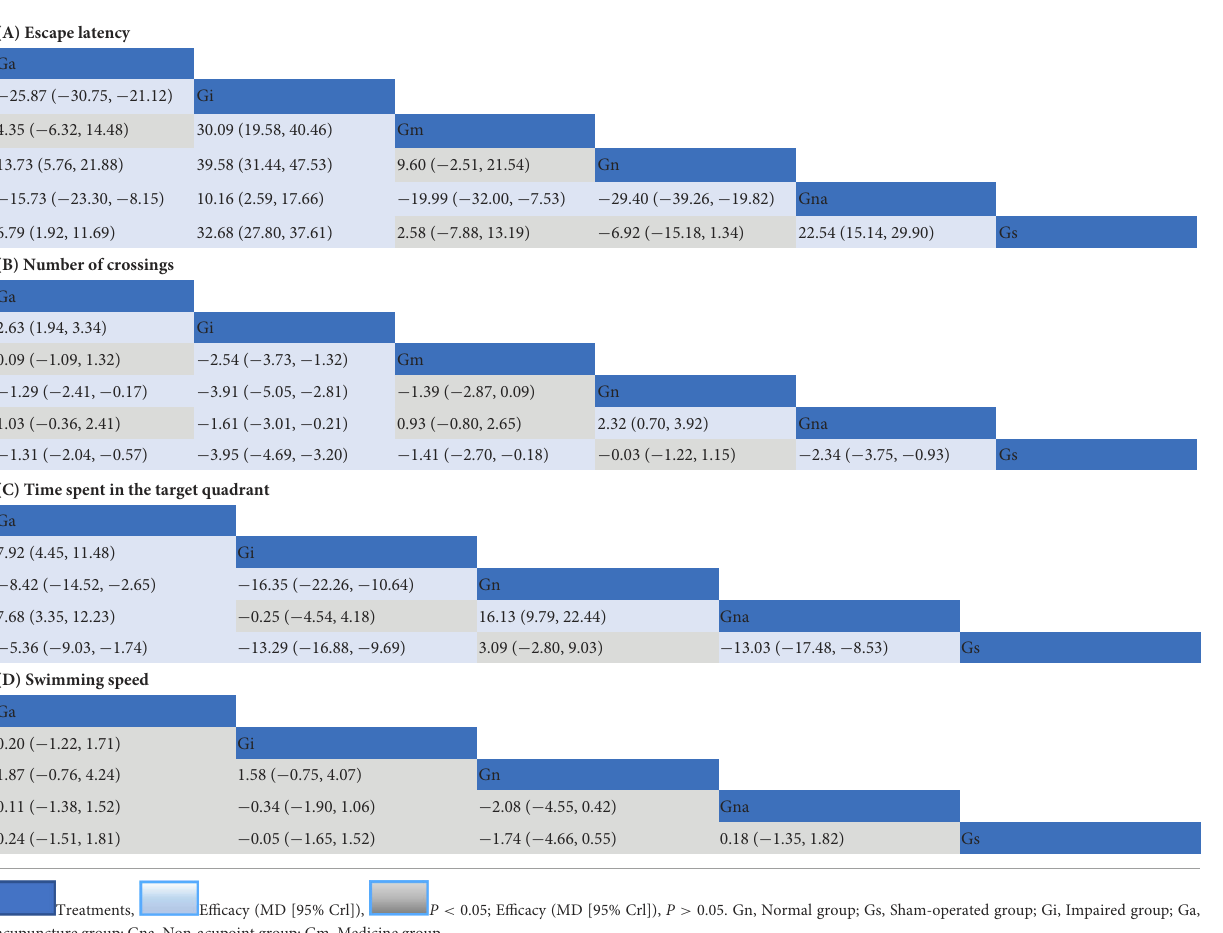
TABLE 1 Network meta-analysis of